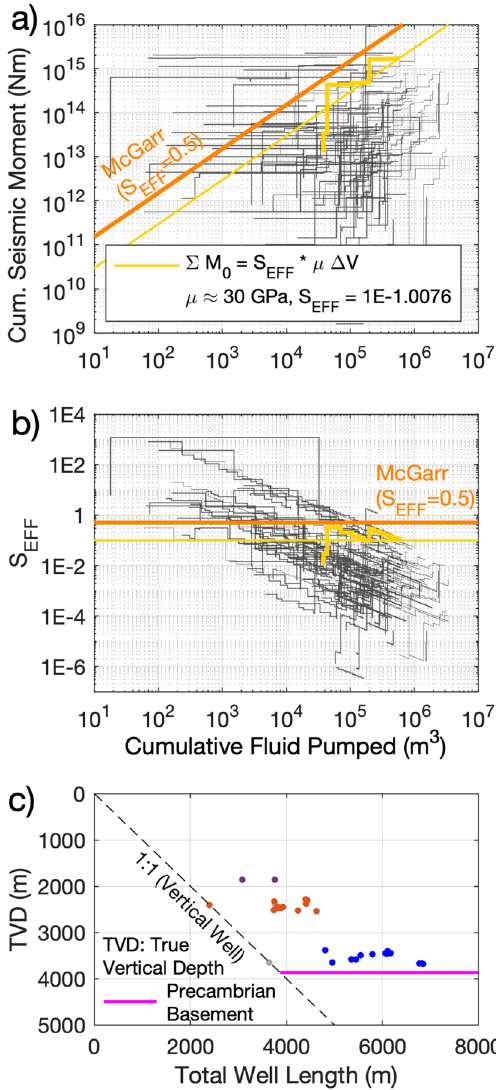
Figure 5. ( a ) Response path of the cumulative fluid pumped in all hydraulic-fractured wells located inside the unit areas of 0.2° in Longitude by 0.1° in Latitude shown in Fig. 4a (in grey), highlighting the response path of the unit area near Fox Creek obtained from the Total Fluid Pumped per well from this area (shown in Fig. 4e), and cumulative seismic moment of all seismic events inside the same area (shown in Fig. 4f near the HF wells, and their magnitudes shown in Fig. 4d). The response path calculated for all unit areas in western Canada, are also shown in Video S2 in the supplementary materials. The variability of the S EFF for this example unit area near Fox Creek, shown in ( b ), shows two clear runaway rupture sequences (similar than the scenario 2 illustrated in Fig. 3b), attributable to the reactivation of two different (but relatively close) faults located inside this unit area. A constant S EFF of 0.5, which corresponds to a seismic cycle with zero stress drop [from Eq. (4)] is also shown in ( a ) and ( b ) for reference. The True Vertical Depth (TVD) of the same hydraulic fractured wells are shown in ( c ), together with the TVD of the Precambrian basement (retrieved from the 3D provincial Geological Model of Alberta 48 ). All geoLOGIC systems ltd. data and software is copyright